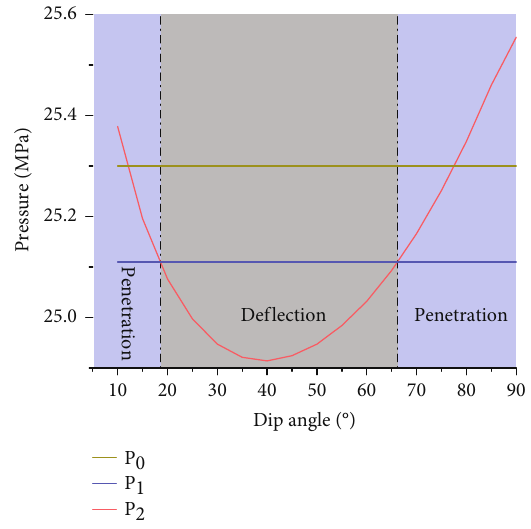
fl uid viscosity. Figure 8: Changes in P